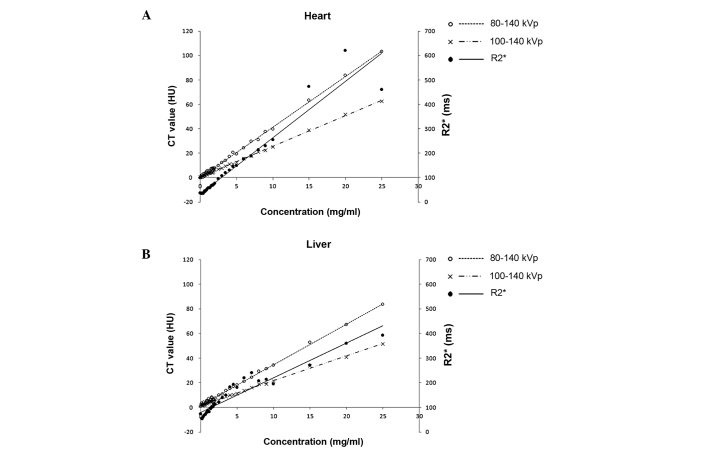
Scatter plots showing the predicted regression lines of DECT ΔH80–140, ΔH100–140 and R2* with iron concentrations in the (A) heart and (B) liver. DECT, dual-energy computed tomography.